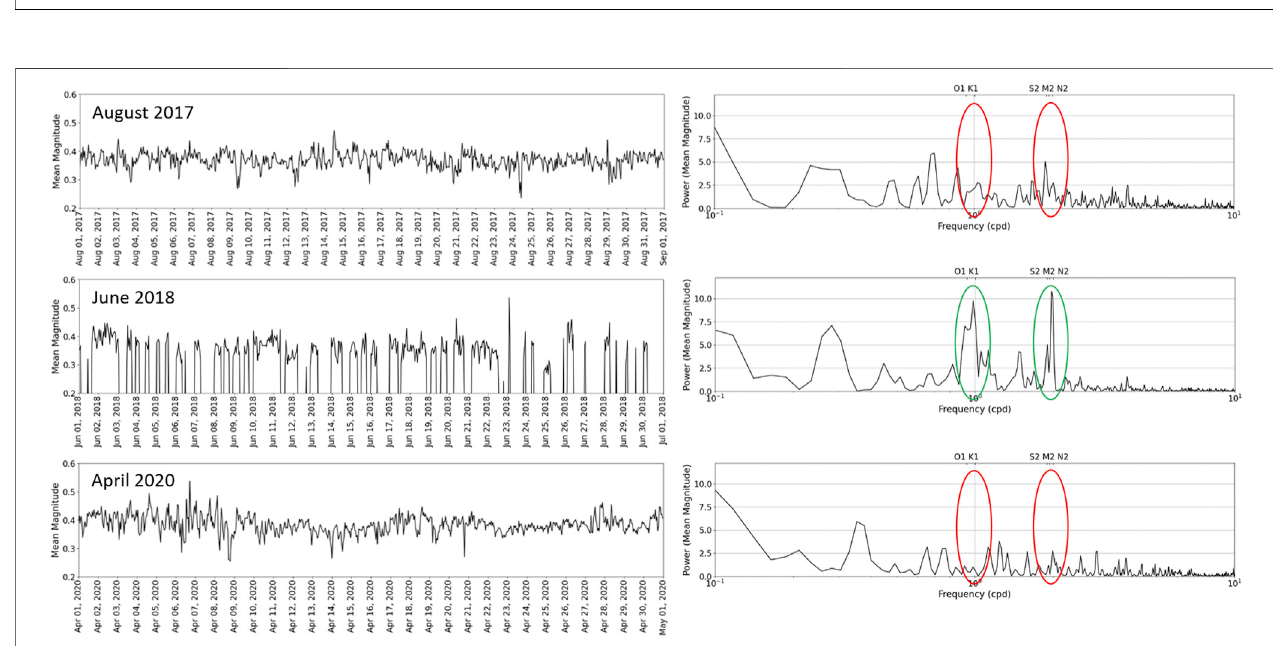
FIGURE 3 | Left: timeseries of mean backscatter for 2 months of continuous venting (August 2017 and April 2020) and 1 month of discontinuous venting (June 2018).Magnitudedata aredimensionless. Right: Corresponding power spectral density plots.Forreadability, thediurnal (O1and K1)andsemi-diurnal (M2,N2,and S2) harmonic constituents of the local tides are reported at the top of each plot. The diurnal and semi-diurnal tidal frequencies are clearly present in the sonar data when venting is discontinuous (green ellipses) but either absent or hardly detectable when venting is continuous (red ellipses).